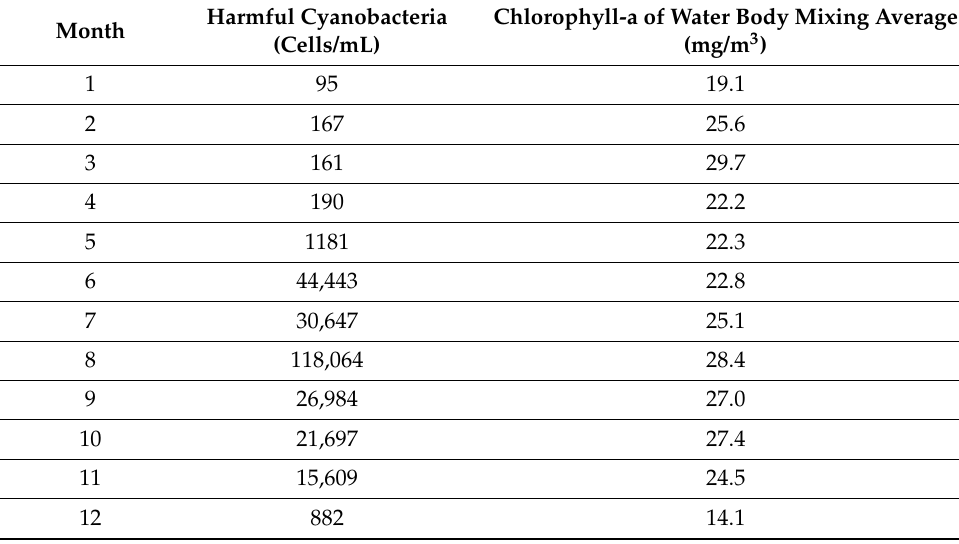
Table A1. Monthly observed values of harmful cyanobacteria and chlorophyll-a.